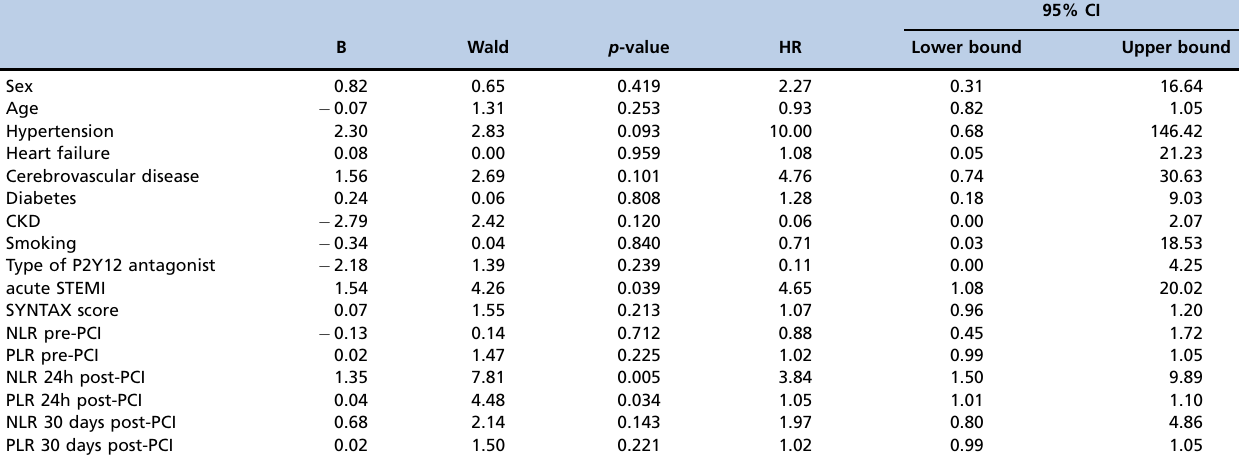
Table 3 - Multiple Cox analysis of the factors predicting MACE in patients with ACS.